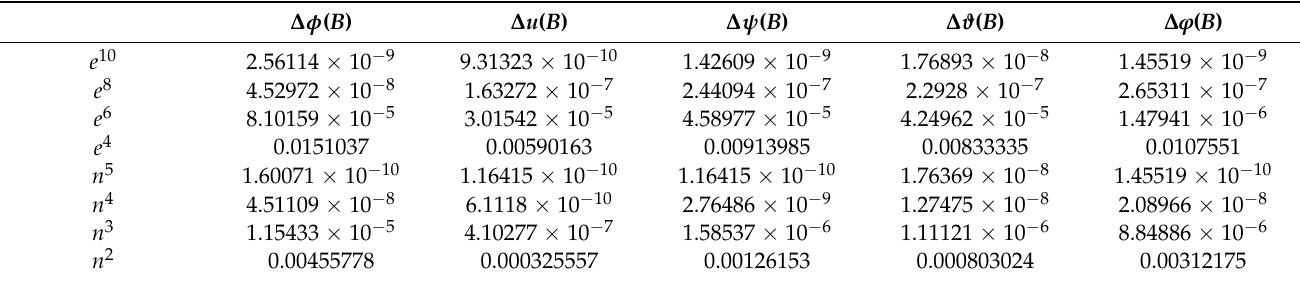
Table 11. Truncation error of common latitude expanded to different orders with geodetic latitude as the variable (units: arc